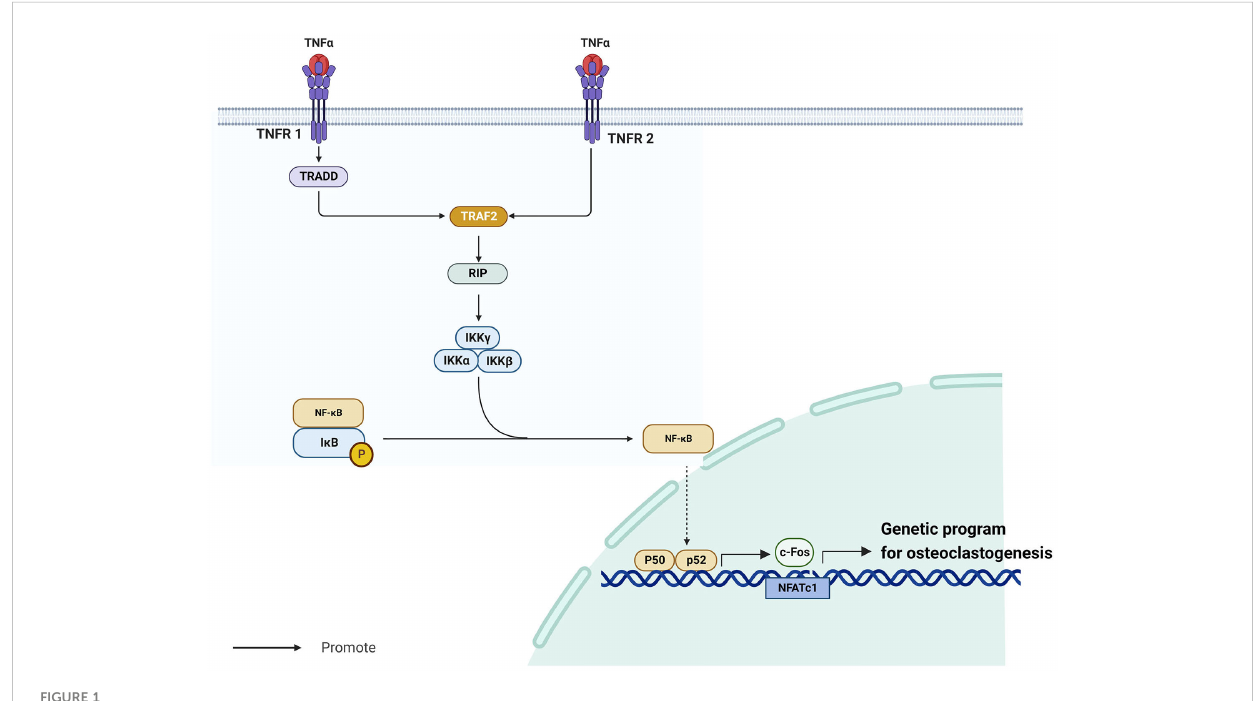
FIGURE 1 TNF- a /NF- k B signaling